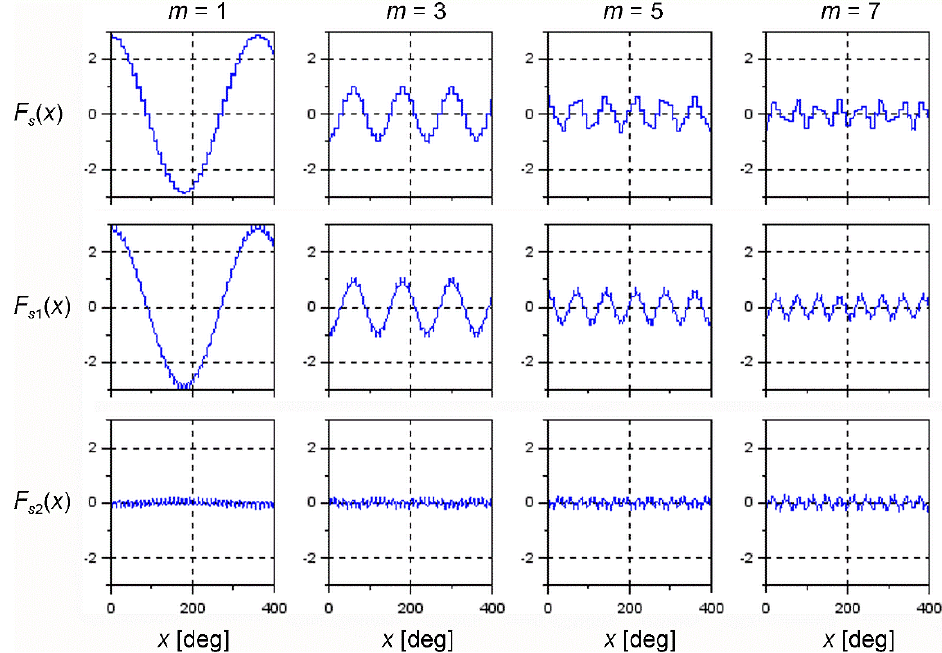
Figure 8. Distributions of MMF for nine-phase winding ( M = 9) of the second type ( S = 2) at t = 0, I μ = 1, and sequence numbers m = 1, 3, 5, and 7.